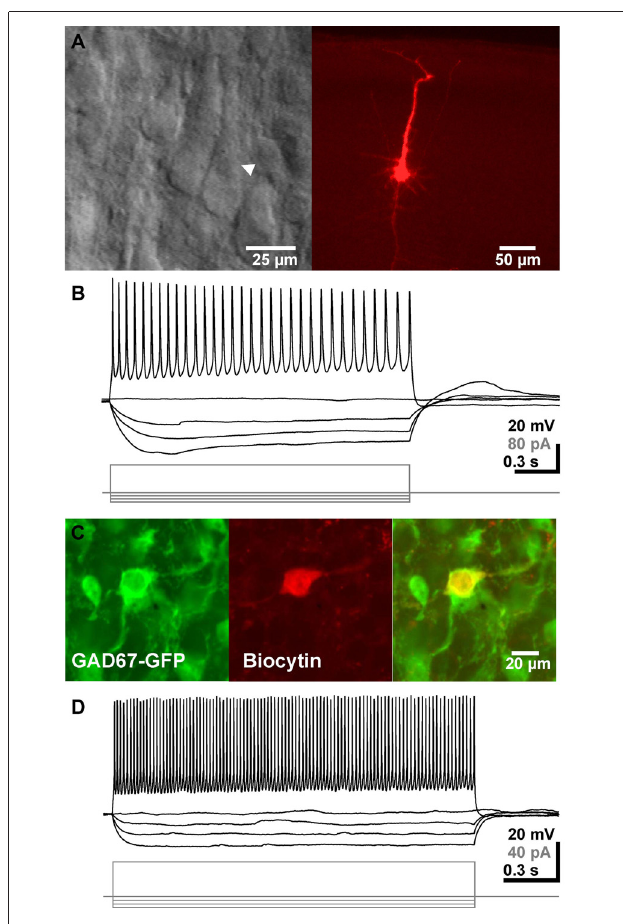
FIGURE 1 | Identification and basic electrophysiological properties of neocortical pyramidal neurons and GABAergic interneurons . (A) Typical interference contrast image of a pyramidal neuron (arrowhead in left image) and the same neuron after biocytin-labeling and subsequent histochemical processing. (B) Voltage-traces of the neuron shown in A upon injection of de- and hyperpolarizing current pulses. (C) Confocal fluorescence images displaying GFP-positive interneurons ( left ), a biocytin-labeled recorded neuron ( middle ) and the merged picture ( right ). (D) Representative